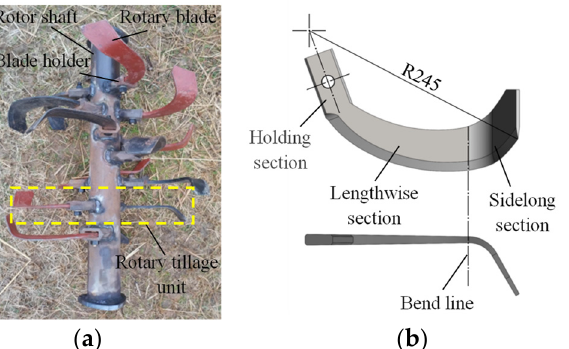
Figure 2. Rotary tillage part: ( a ) overall structure of rotary tillage part; ( b ) rotary blade.